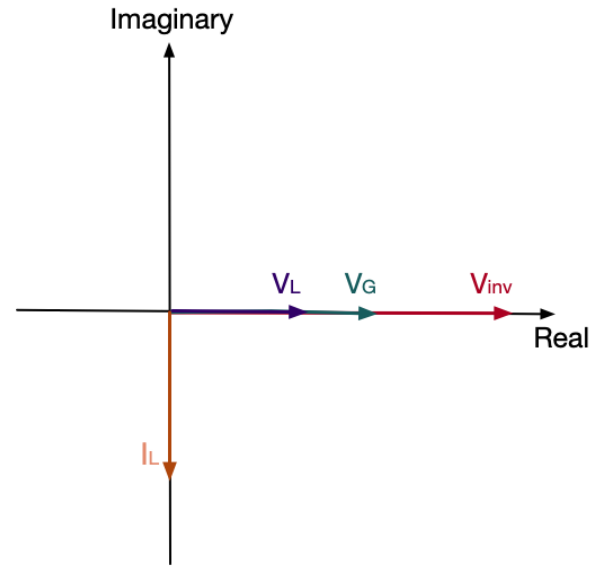
Figure 4. Voltage and current vectors in reactive power compensation